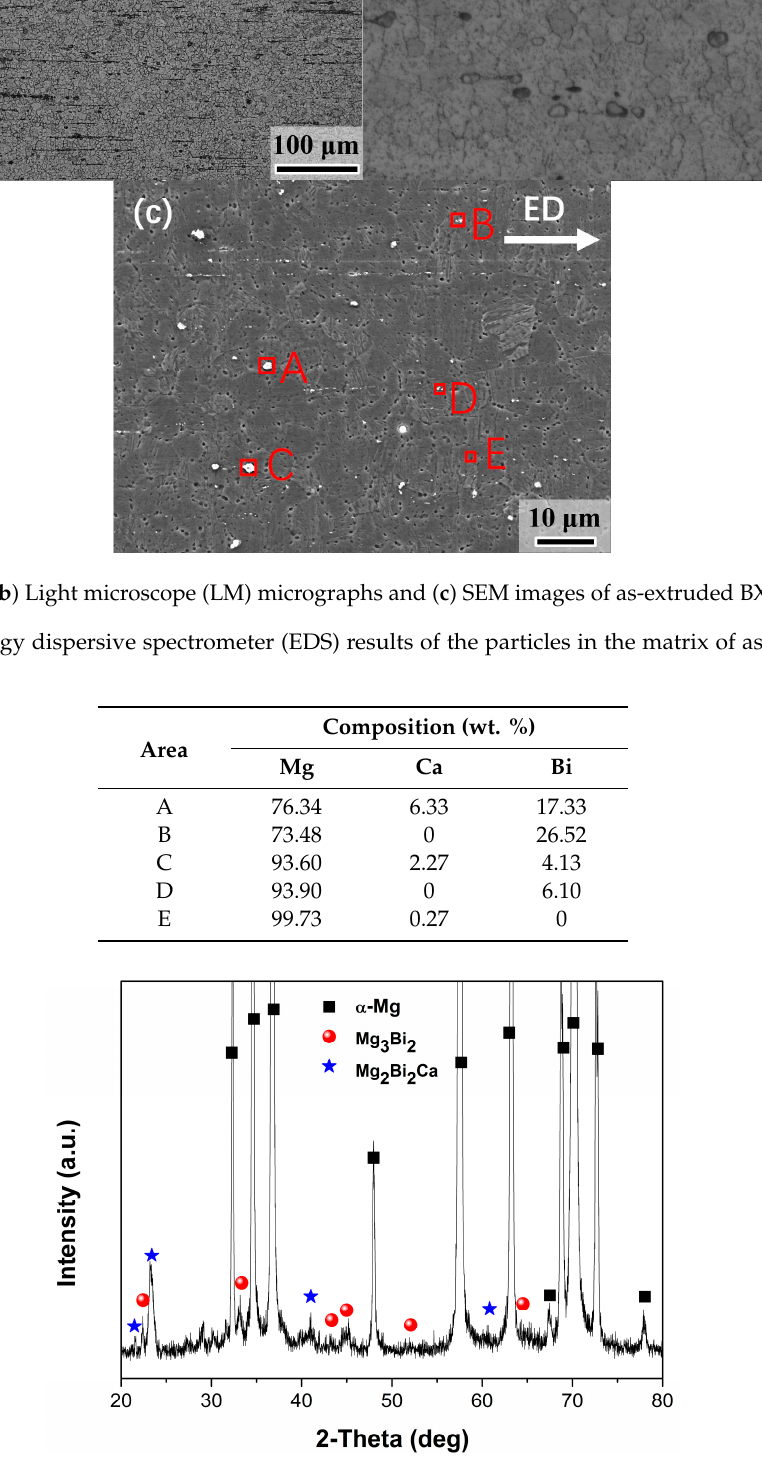
Figure 4. X-ray di ff raction (XRD) pattern of as-extruded BX11 Figure 4. X-ray diffraction (XRD) pattern of as-extruded BX11 alloy.